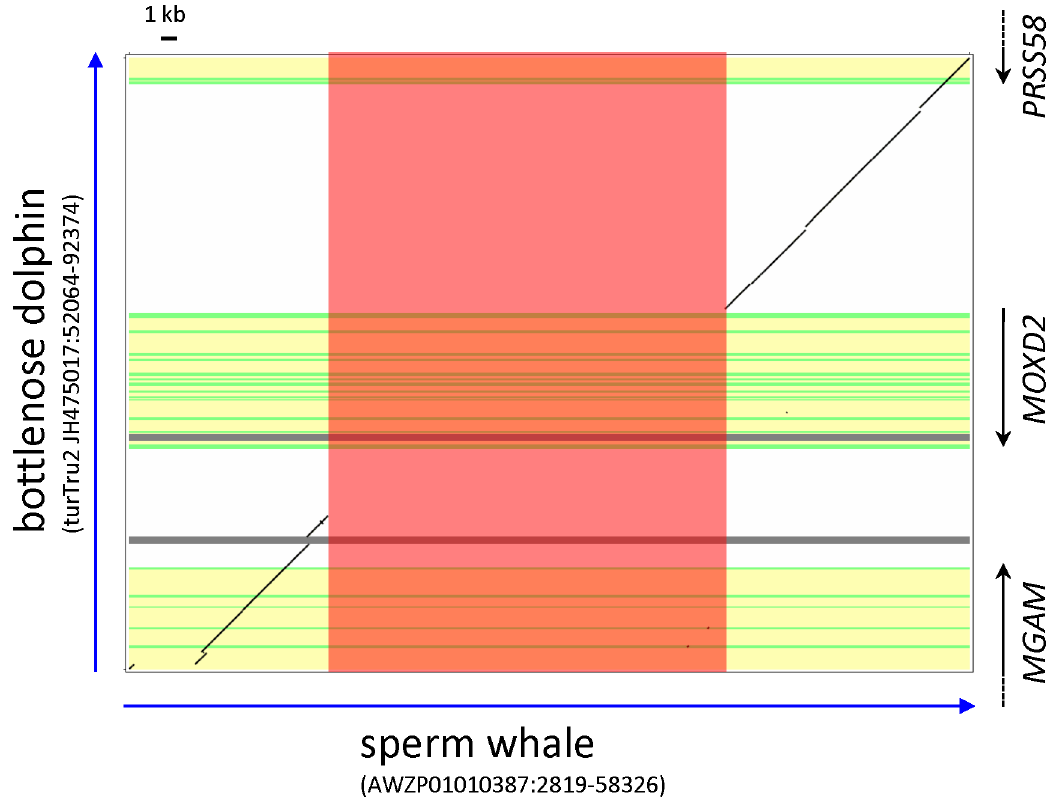
Figure 5. Complete deletion of the MOXD2 gene in the sperm whale. Sequence comparison of the sperm whale ( Physeter macrocephalus ) (horizontal) and the bottlenose dolphin ( Tursiops truncatus ) (vertical) MOXD2 gene loci is presented. In the sperm whale, the MOXD2 genomic region was replaced with a repeat-rich segment (red box). The bottlenose dolphin MGAM , MOXD2 , and PRSS58 genes are marked at the right, with coding regions and introns in green and yellow, respectively. Gray horizontal lines indicate gaps in the bottlenose dolphin genome assembly